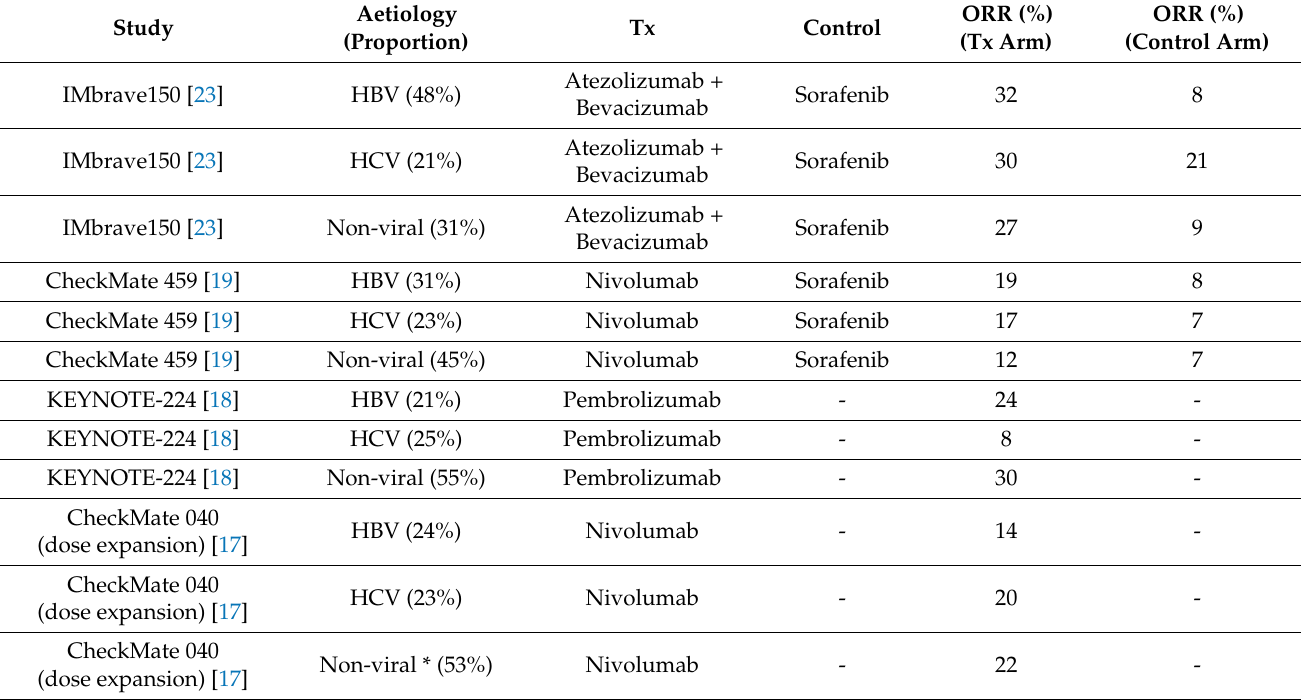
Table 3. Summary of objective response rates according to underlying liver diseases in major